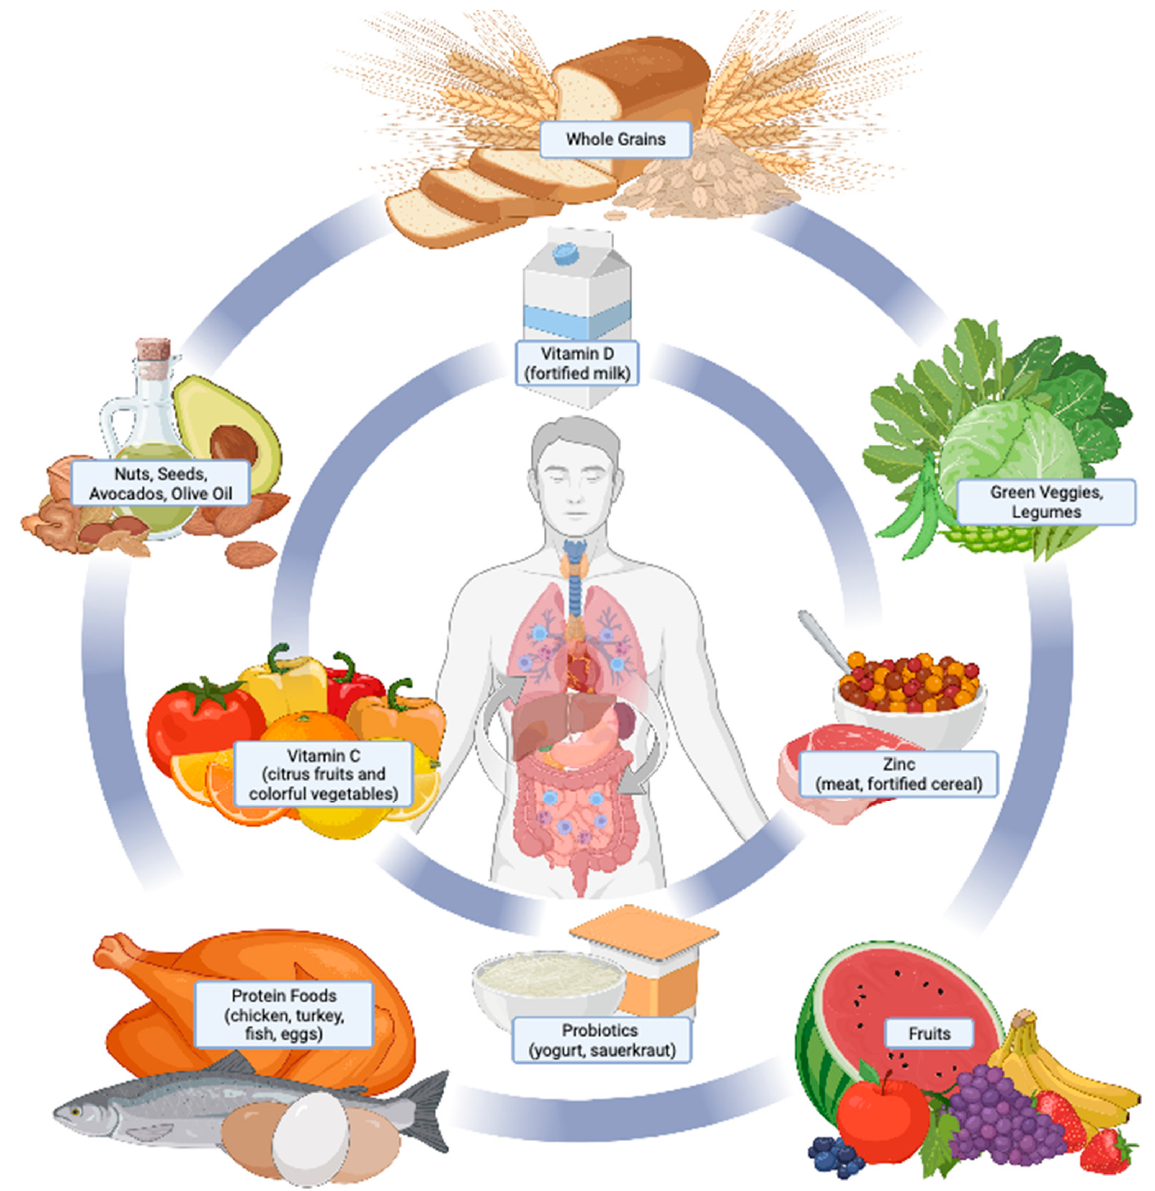
Figure 1. Overview of nutritional therapies in the treatment and management of COVID-19 and PASC. Nutrition plays a critical role in human health and the prevention and treatment of PASC.